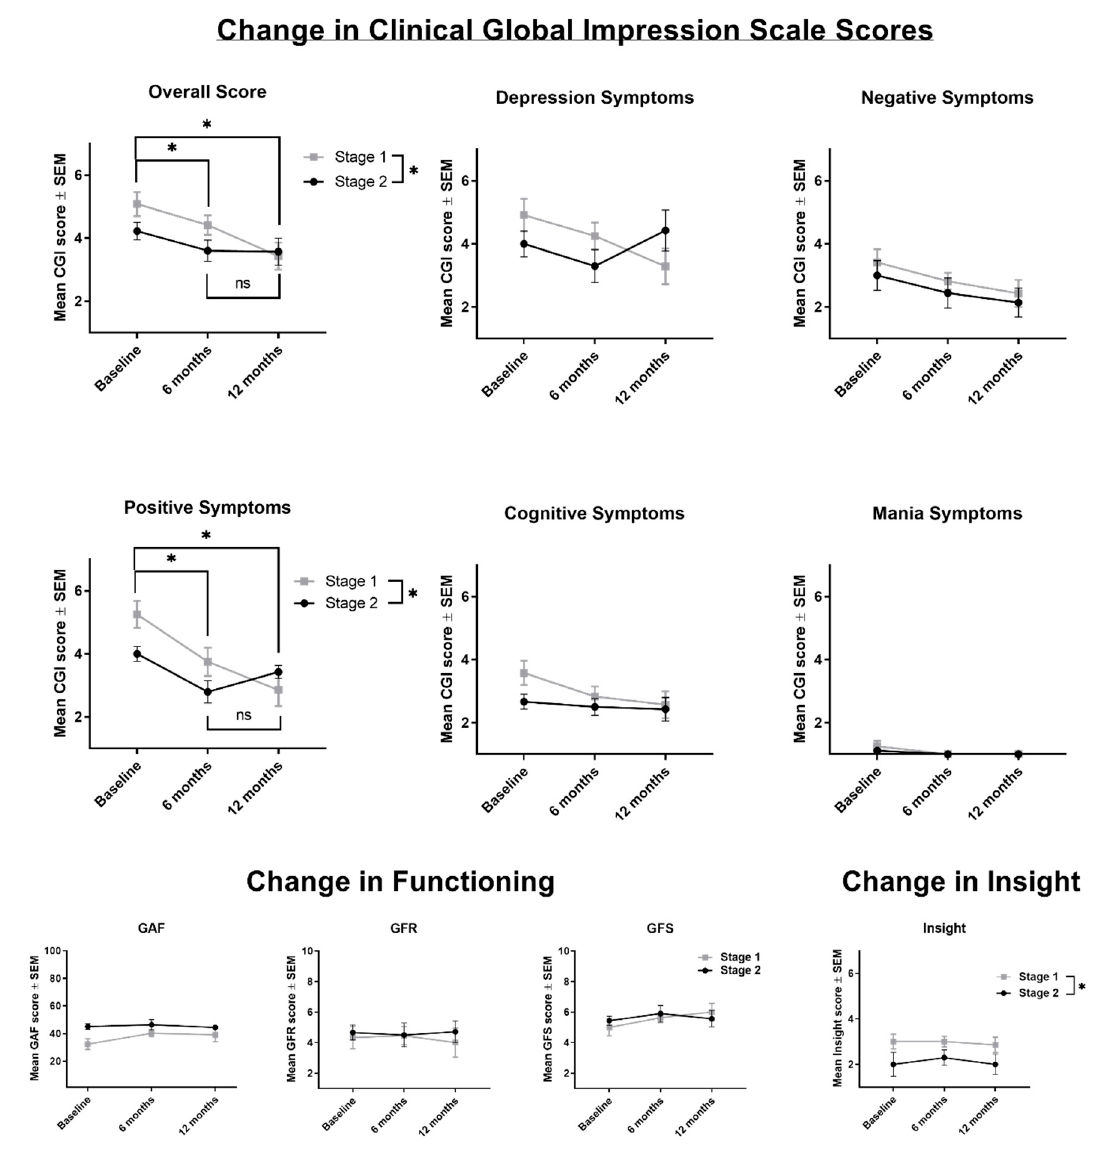
Figure 3. Changes in outcomes across 12 months of treatment. Note. GAF = Global Assessment of Functioning; GFR = Global Functioning Role Scale; GFS = Global Functioning Social Scale; NSSIB = Non-suicidal self-injurious behavior. Stage 1 n = 12; Stage 2 n = 10. N s di ff ered by time point. For the overall, positive, depression, mania, and cognitive CGI data, the n s were as follows: Overall: Stage 1: 12 (baseline), 12 (6 months), 7 (12 months); Stage 2: 9 (baseline), 10 (6 months), 7 (12 months). For negative CGI scores: Stage 1: 12 (baseline), 11 (6 months), 7 (12 months); Stage 2: 9 (baseline), 9 (6 months), 7 (12 months). For the functioning data, the n s were as follows: GAF: Stage 1: 12 (baseline), 12 (6 months), 7 (12 months); Stage 2: 10 (baseline), 10 (6 months), 7 (12 months). GFR: Stage 1: 12 (baseline), 11 (6 months), 7 (12 months); Stage 2: 9 (baseline), 10 (6 months), 7 (12 months). GFS: Stage 1: 12 (baseline), 11 (6 months), 7 (12 months); Stage 2: 6 (baseline), 10 (6 months), 7 (12 months). Finally, the ordinal regression model significantly predicted insight symptoms, χ 2 (3) = 8.42, p = 0.04; pseudo R 2 = 0.16. The odds ratio of having less insight for Stage 1 versus Stage 2 was 4.34 (95% change over time ( p =